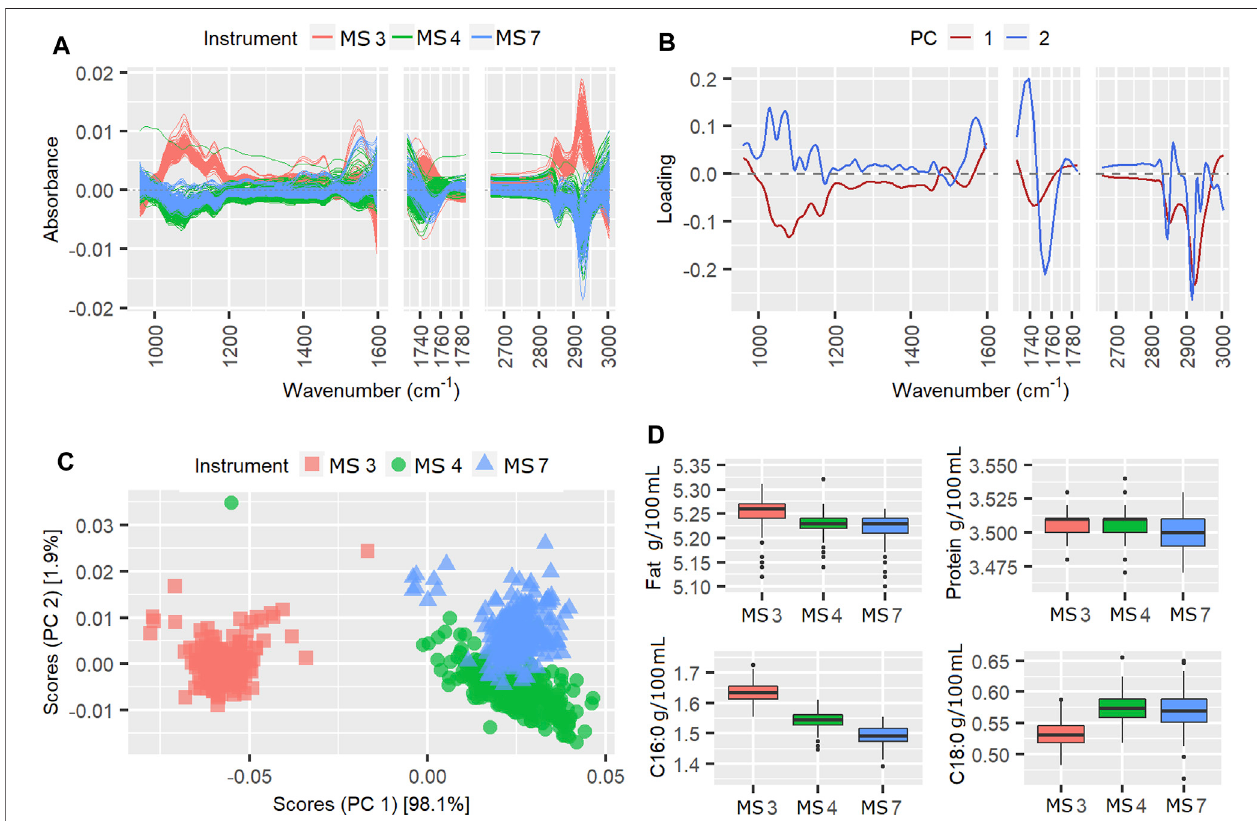
FIGURE5 | Mean centered spectra (A) , instrumentloading plots (B) and scores (C) for pilotspectrafrom week 217, inwhich the TSSQ(adj) exceeded 3standard deviations. Boxplots (D) show the predicted fat, protein, C16:0 and C18:0 values from each instrument and their mean values and standard deviations (SDs), marked * for 1SD, ** for 2SDs and *** for 3SDs greater than the SD of the 177 weeks TSSQ (adj